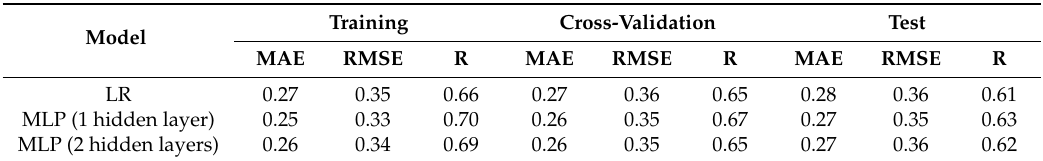
Table 5. Comparison of multi-layer perceptron (MLP; one and two hidden layers), and LR model’ performance for predicting log (STIR) in the continental US. Model Training